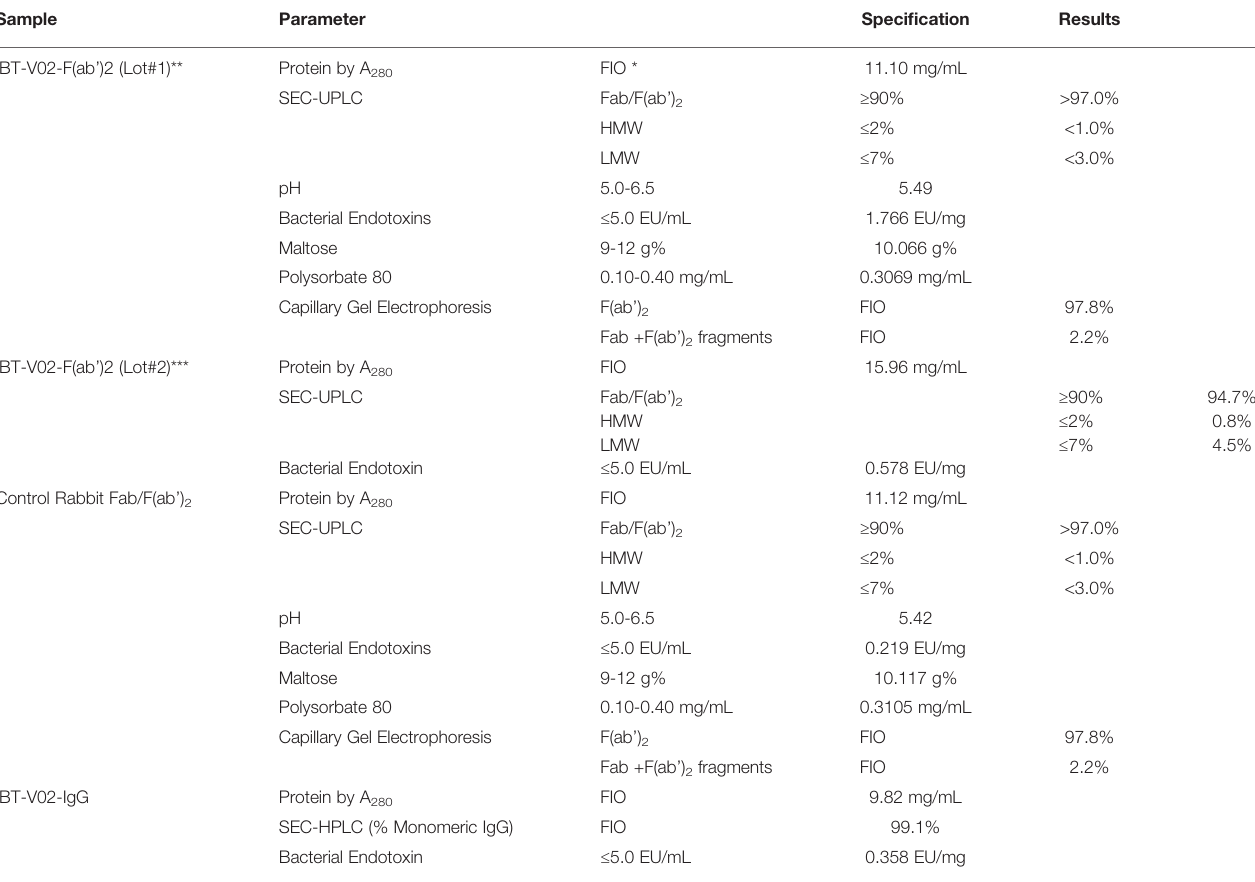
TABLE 1 | Test Articles and Control Articles with Characterization Parameters. All test articles and controls met speci fi cations for in vitro and in vivo testing.